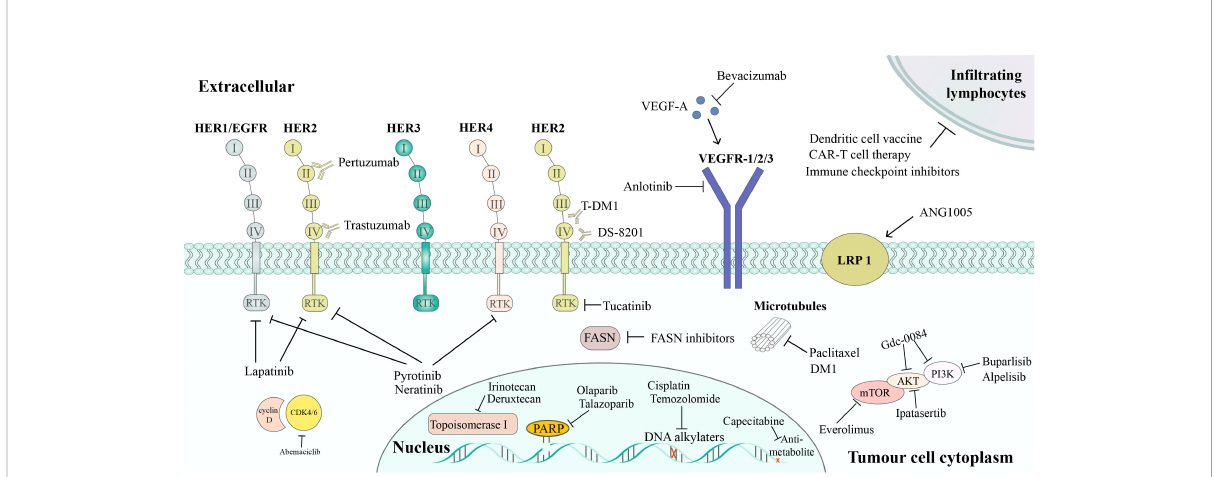
FIGURE 1 Targeted therapy of BCBM treatment. HER2 inhibitors includes: trastuzumab, which binds to subdomain IV of HER2, leading to the inhibition of HER2 signaling; pertuzumab, which binds to subdomain II of HER2, preventing HER2/HER3 dimerization; T-DM1, an ADC of trastuzumab and the cytotoxic agent DM1; DS-8201, another ADC that combines trastuzumab and deruxtecan, a potent topoisomerase I inhibitor; lapatinib, which is a reversible TKI of HER1 and HER2; tucatinib, a speci fi c HER2 TKI; pyrotinib and neratinib, TKIs that inhibits HER1, HER2, and HER4. Pathway inhibitors include: PI3K/Akt/mTOR pathway inhibitors (buparlisib, alpelisib, Gdc-0084, ipatasertib, and everolimus); CDK4/6 inhibitors (abemaciclib), VEGF pathway inhibitors (anlotinib, bevacizumab). Other therapies include: PARP inhibitors, FASN inhibitors, chemotherapy, and